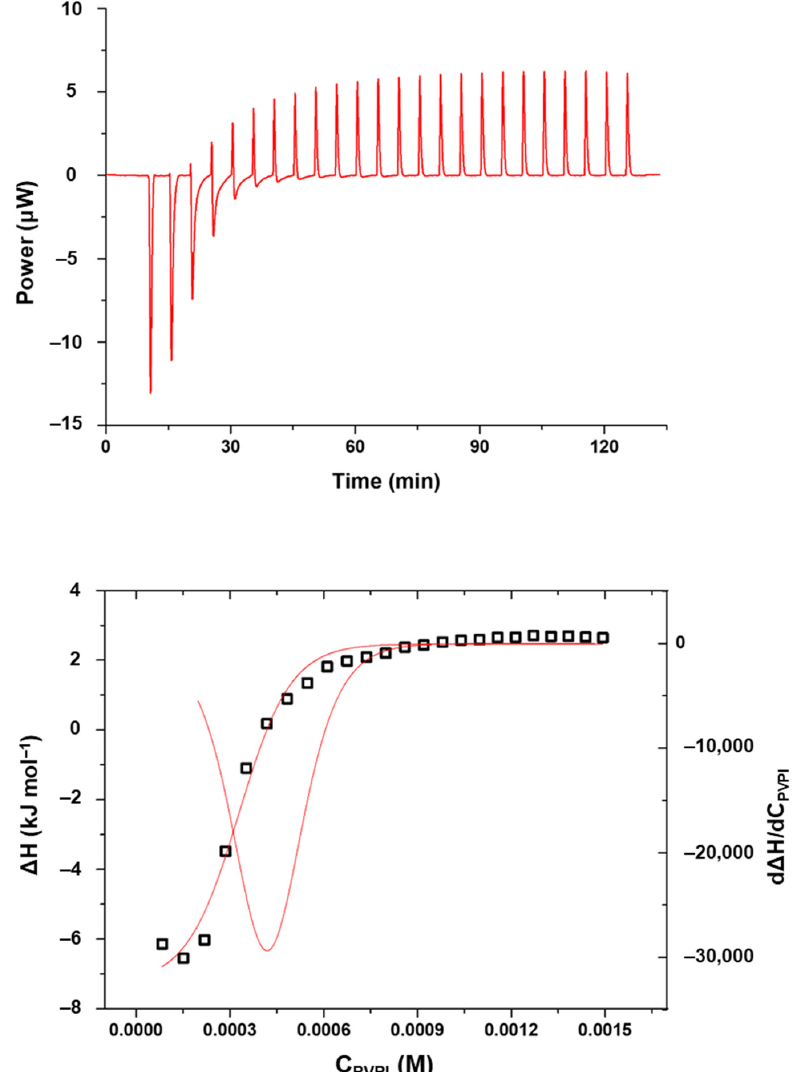
Figure 7. ITC titration of a 2.5 mg/mL PVPI solution into SC4OC6 1 mM in PCB at 25 °C ( top ); enthalpy of reaction as a function of the total concentration of PVPI in the calorimetric cell (C PVPI is calculated as the monomer unit; squares: enthalpy values, red lines: curve fitting and first derivative) ( bottom ).